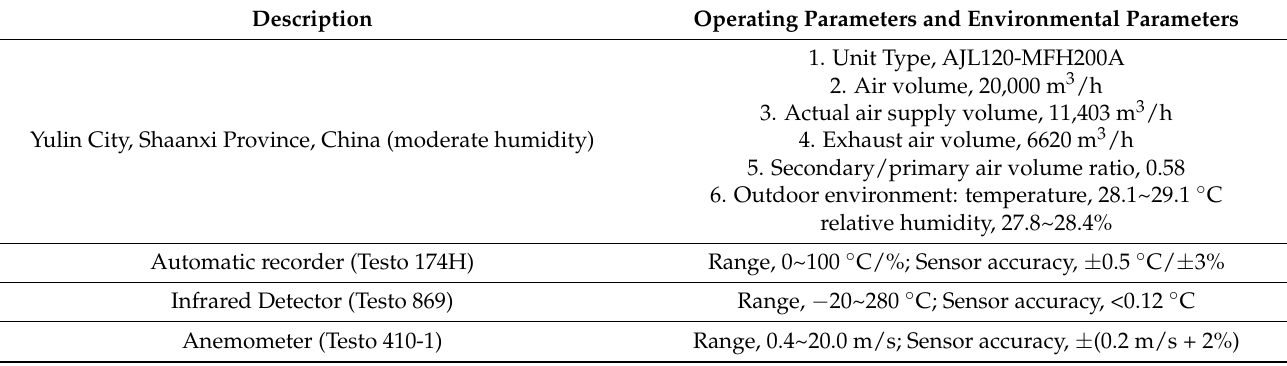
Table 1. Instrumental and environmental parameters for date collection. Description